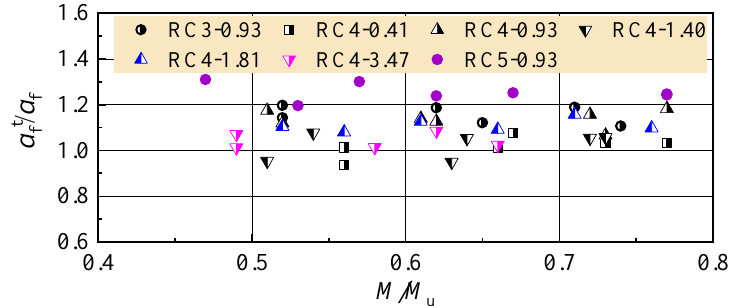
Figure 11 . Ratios of test to computed values of mid-span deflection.